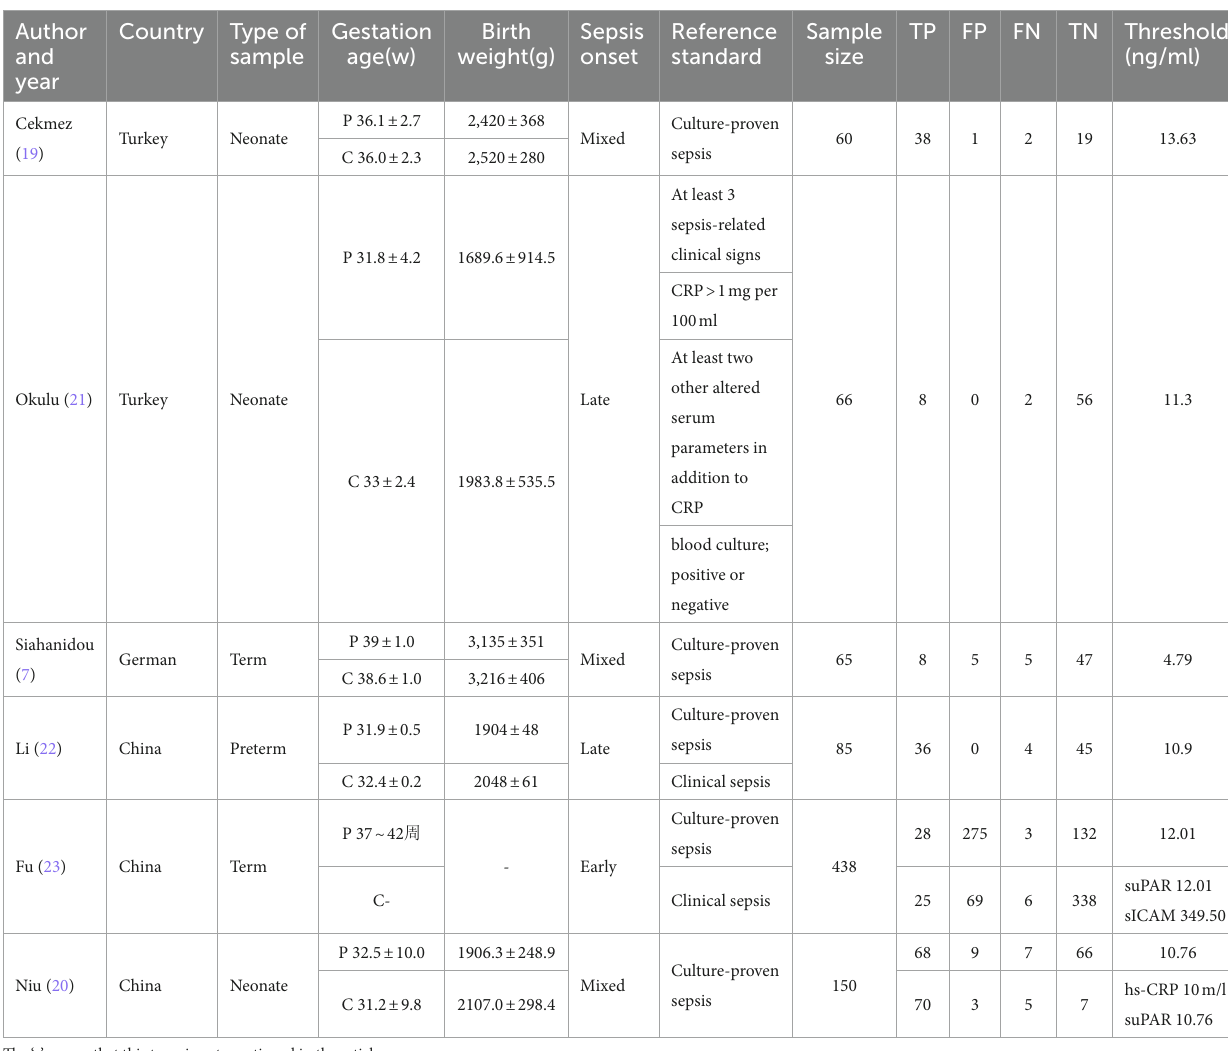
TABLE 1 Characteristics of the included